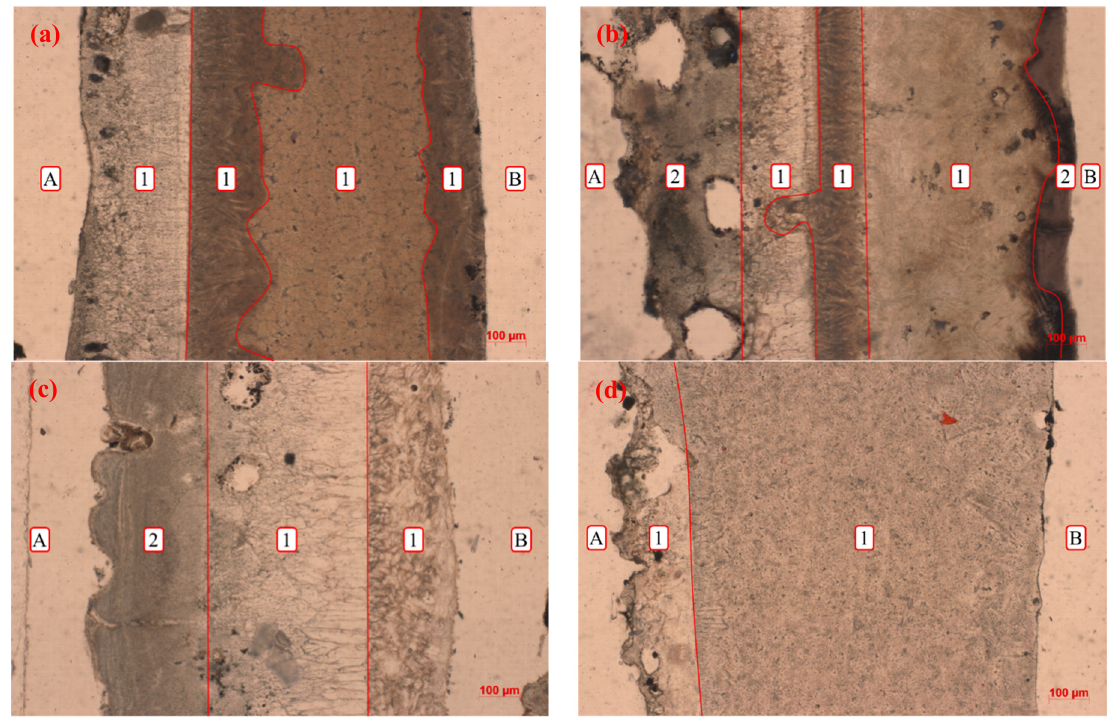
Figure 8. Layered structures of flux films: ( a ) film 1; ( b ) film 2; ( c ) film 3; ( d ) film 4; A—the mold side; B—the shell side; 1—crystallization layer; 2—glass layer.